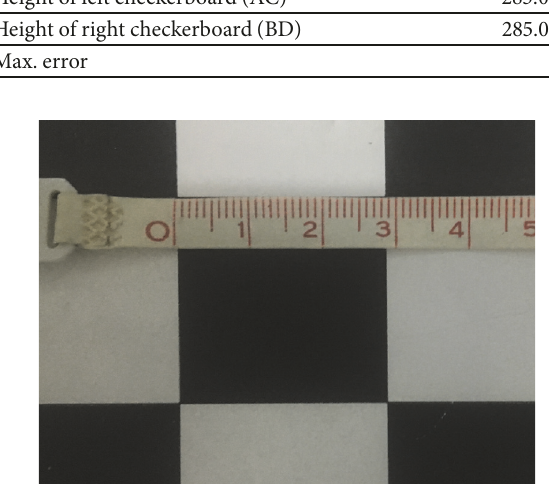
Figure 9: The real dimension of each small square has the size of 28.5 × 28.5𝑚𝑚 2 in the checkerboard reconstructed as shown in Figure 10.